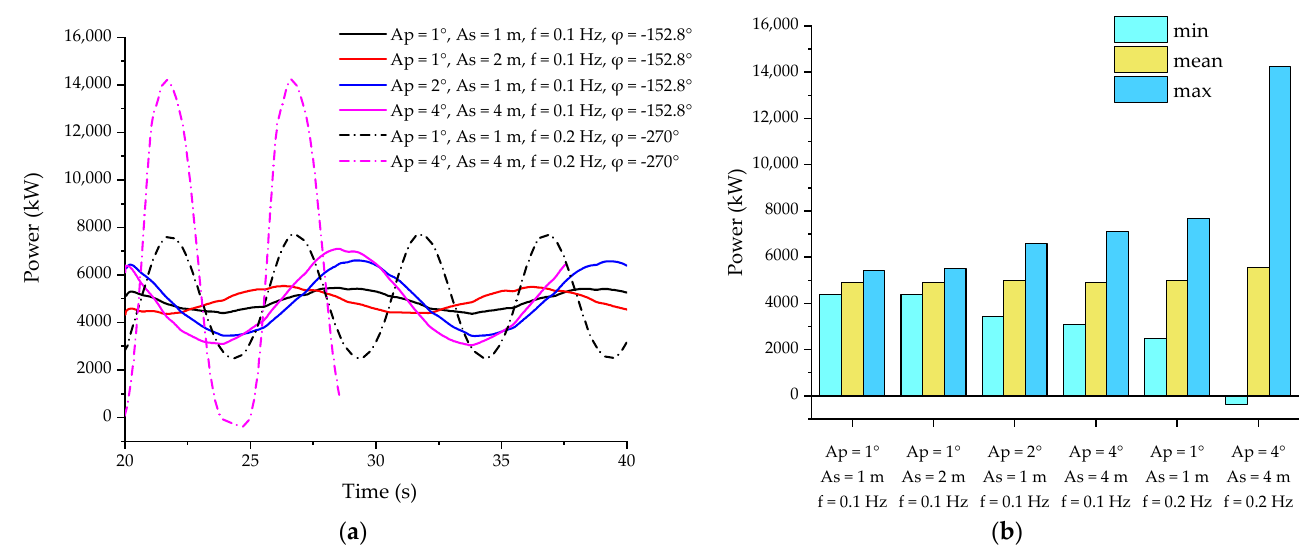
Figure 19. Power performance under combined motion with phase difference. ( a ) Power variation versus time; ( b ) the average and extreme power.